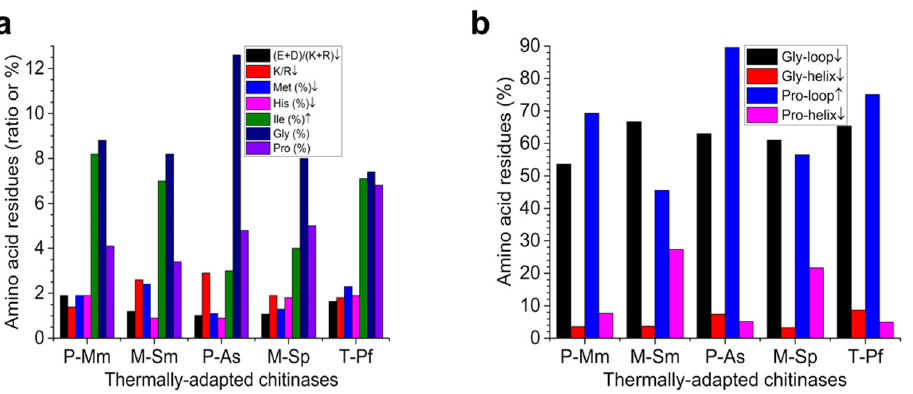
Figure 1. Compositional features in thermally adapted chitinases. ( a ) The relative number of amino acid residues (ratio or %). ( b ) Gly and Pro in the secondary structures (%). All features were analyzed using the ProtParam tool or PDB DeepView. ↑ , higher value of the parameter is associated with higher stability; ↓ , higher value of the parameter is associated with lower stability. P, psychrophilic; M, mesophilic; T, thermophilic. Mm, M. marina ; Sm, S. marcescens; As, Arthrobacter sp.; Sp, S. proteamaculans ; Pf, P. furiosus.